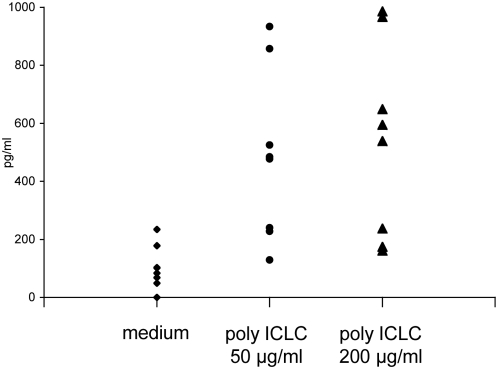
Monkey DCs secrete CXCL10 upon stimulation with poly ICLC.Monocyte-derived DCs were generated from rhesus macaque CD14+ monocytes and either stimulated with poly ICLC at the indicated concentrations or left in medium alone. CXCL10 concentrations in the supernatants collected 48 hours later were determined by ELISA. Results of seven independent experiments are given, the horizontal lines indicate the mean concentrations.